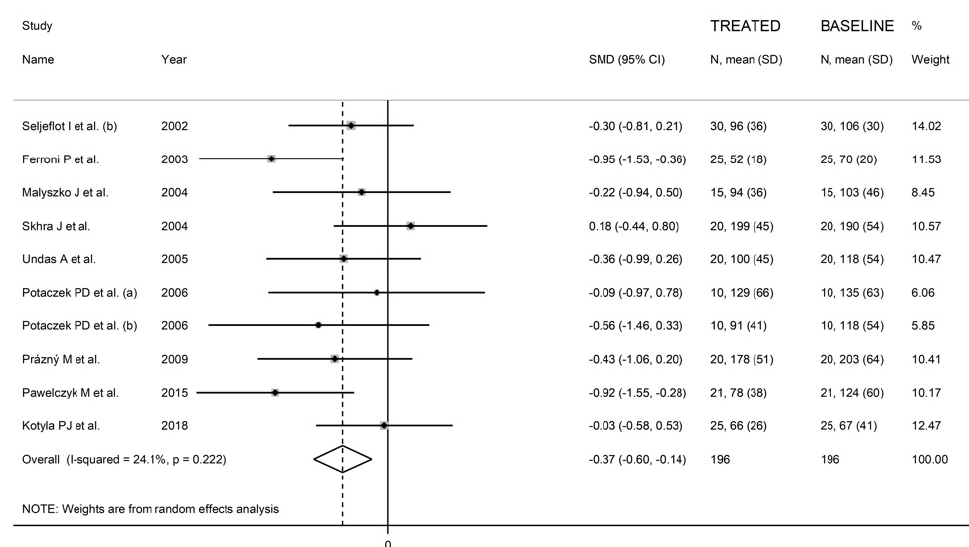
Figure 8. Forest plot of a sub-group of 10 studies examining P-Selectin concentrations, homogeneous for statin used and continent.